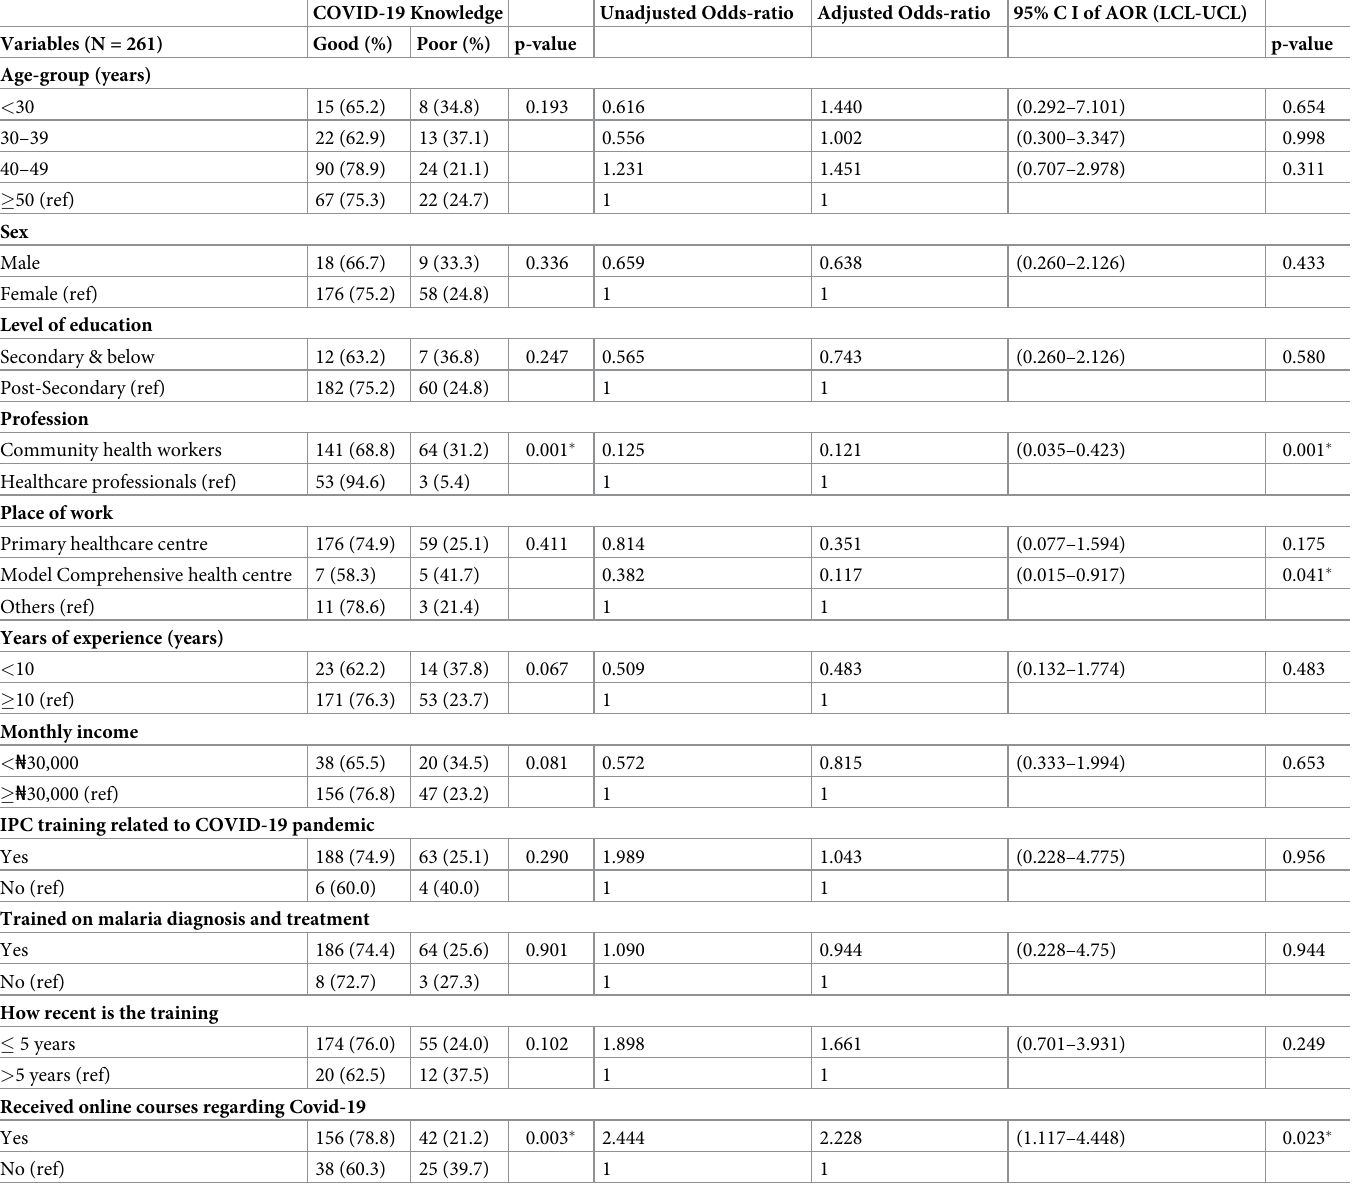
Table 3. Factors influencing COVID-19 knowledge of healthcare